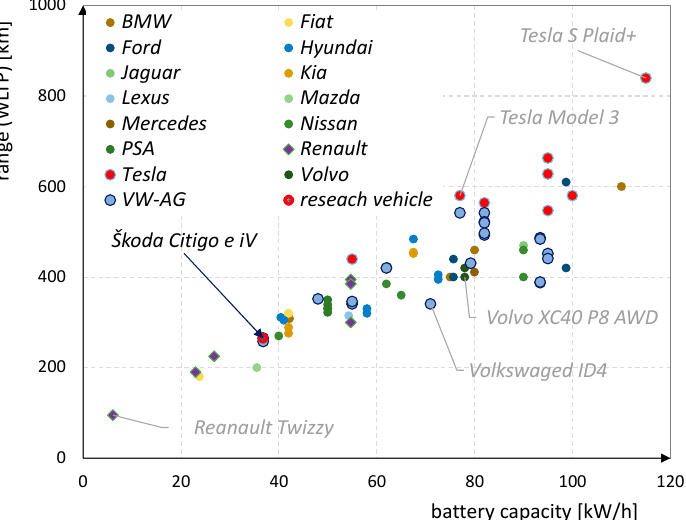
Figure 5. Ranges of various EVs, depending on the battery capacity according to WLTP tests [45,46].